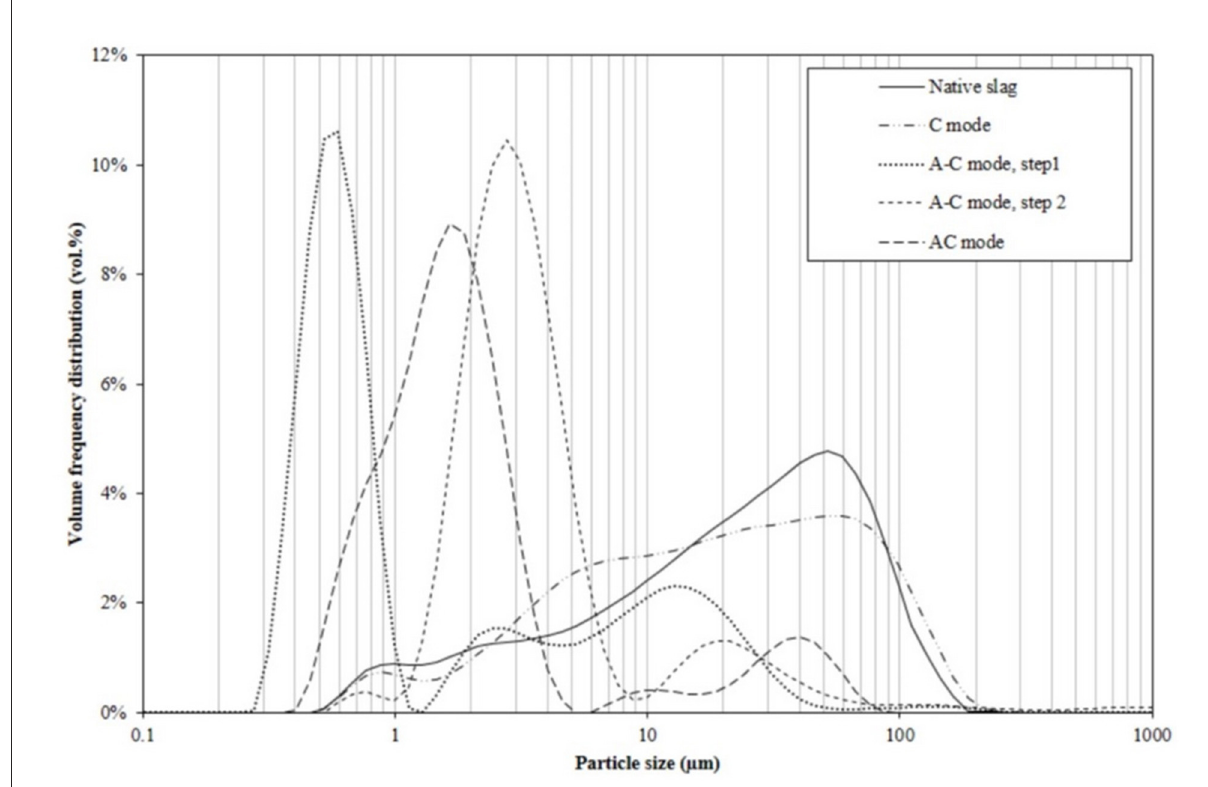
FIGURE5 PSD by volume for ferronickel slag feed and carbonation products from C, A-C, and AC